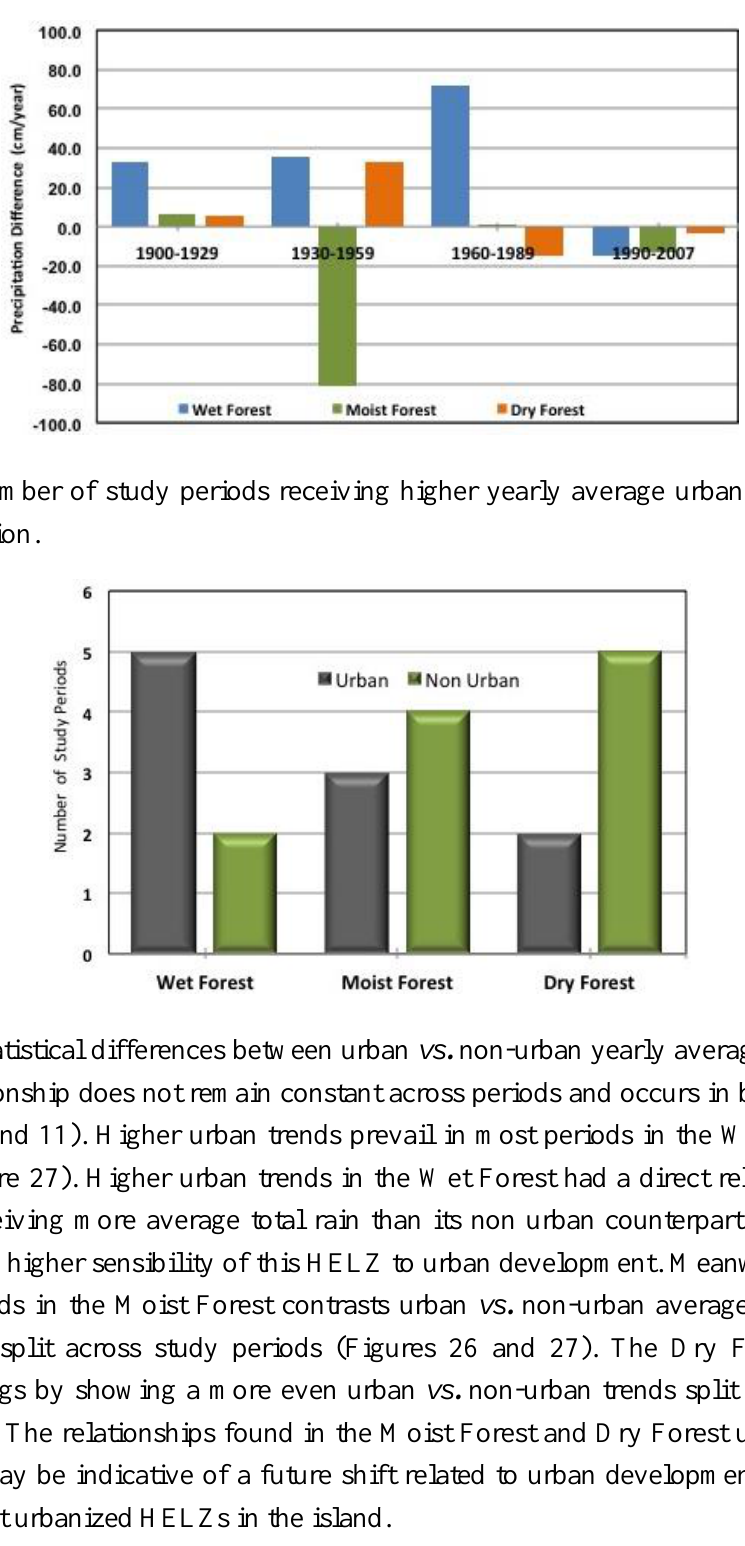
Figure 25. Yearly average total precipitation urban vs. non-urban difference.